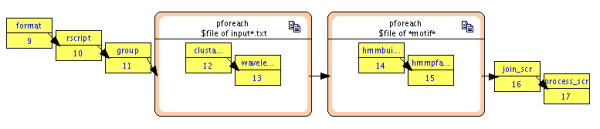
An allergenicity prediction workflow. The allergenicity prediction workflow from [23] constructed in Wildfire. The components in this workflow are all custom applications, or custom scripts calling standard applications. Components format, group, join_scr and process_scr are administrative programs which translate and convert files from one format to another. Component rscript uses the R-project to cluster the amino acid sequences from a database of known allergens. For each cluster, we align its sequences and use a wavelet algorithm to predict motifs. The resulting motifs are used to construct HMM profiles using hmmbuild. Finally, we use these profiles with hmmpfam to predict allergenic sequences. Components join_scr and process_scr collate and summarise the results.